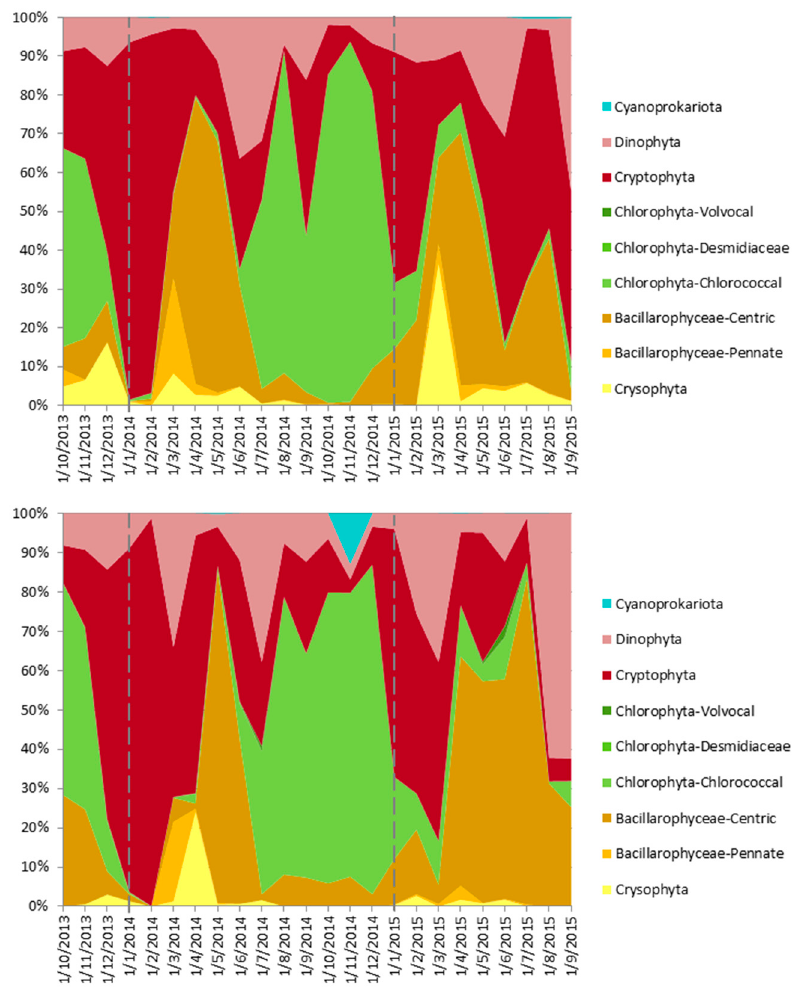
Figure 7. Taxonomic phytoplankton groups with their biovolume and relative dominance (%) in the epi- ( upper graph ) and the metalimnion ( lower graph ) from October 2013 to September 2015 (abscissa).